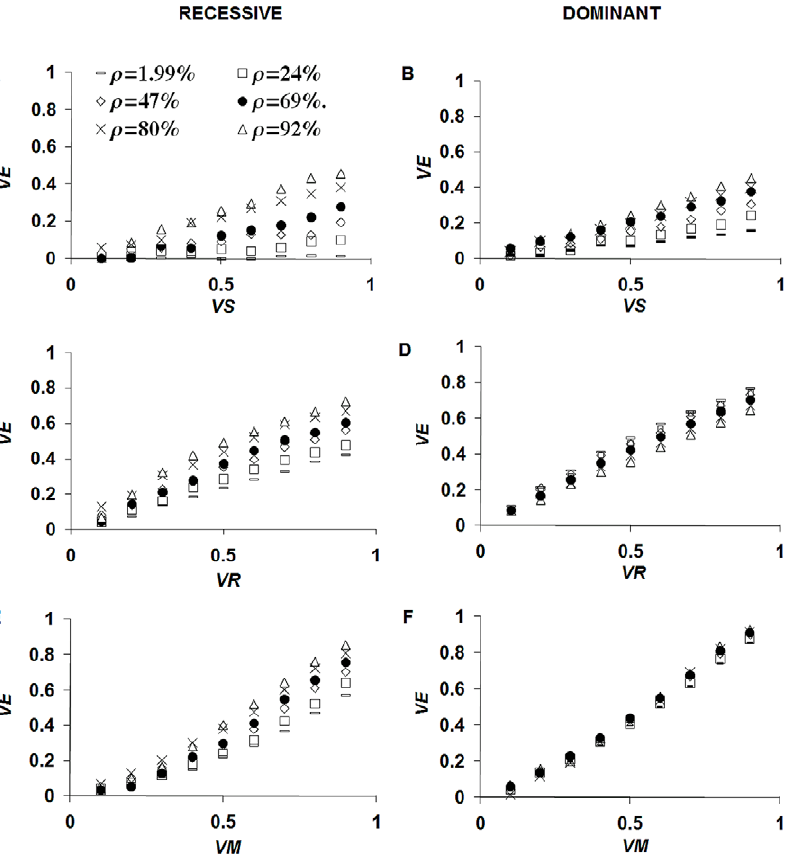
Figure 3. Population-level vaccine effectiveness ( VE ), assuming that density dependence acts on the fecundity of established parasites, and that 50% of the host population is effectively vaccinated (Simulation parameters in Table 1). Vaccines can reduce the host susceptibility to infection (A–B), by a proportion VS , or the female parasite reproductive rate (C–D), by a proportion VR , or the parasite lifespan (E–F), by a proportion VM . Vaccines reducing the parasite fecundity and vaccines reducing the parasite lifespan are more efficacious than vaccines reducing host susceptibility by the same proportion. Low reductions ( , 50%) in female reproductive rate have marginally higher impact than equal proportional reductions in adult worm lifespan. The impact on recessive alleles (A–C–D) grows with r , the degree of host-population mixing. The impact on dominant alleles increases with (B), decreases with (D) or is independent of (F) r , depending on the biological action of the vaccine.